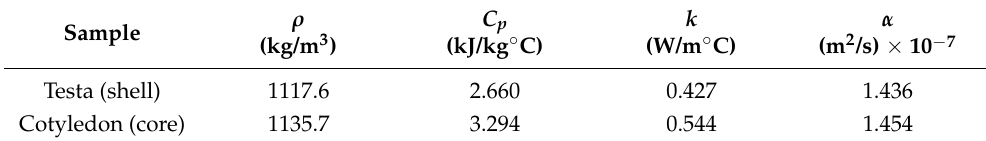
Table 2. The thermophysical properties of the Ecuadorian echo type of cocoa CCN51 at 50 ◦ C.